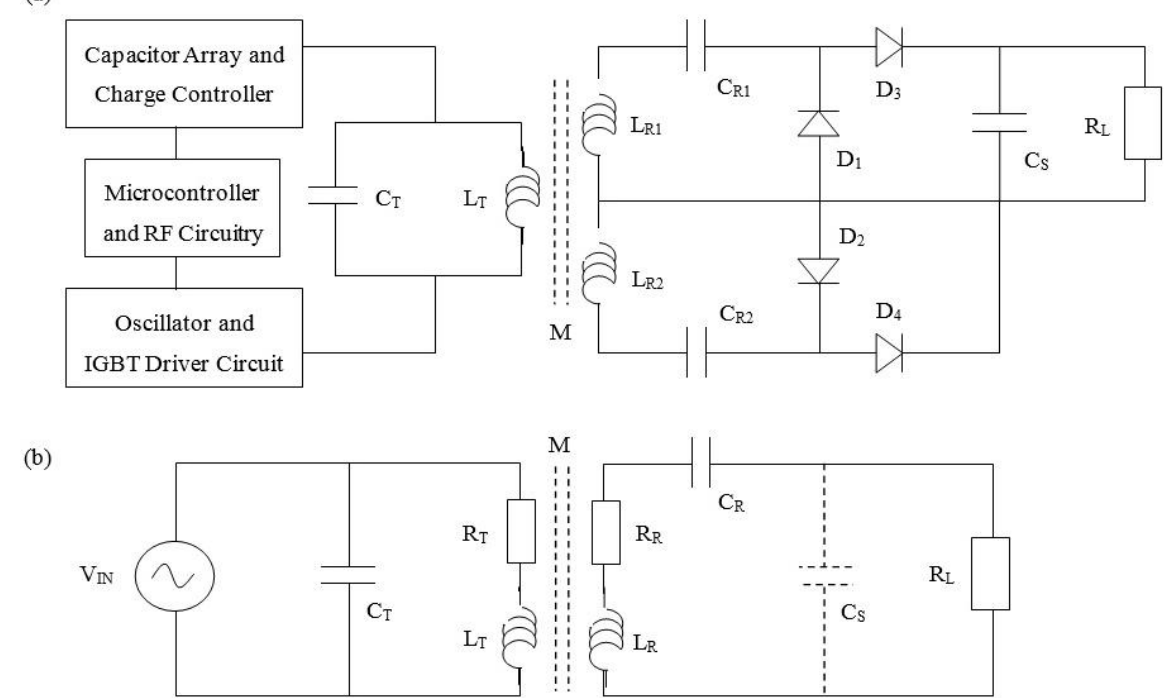
Figure 3. ( a ) Implantable receiver architecture and ( b ) simplified circuit used for